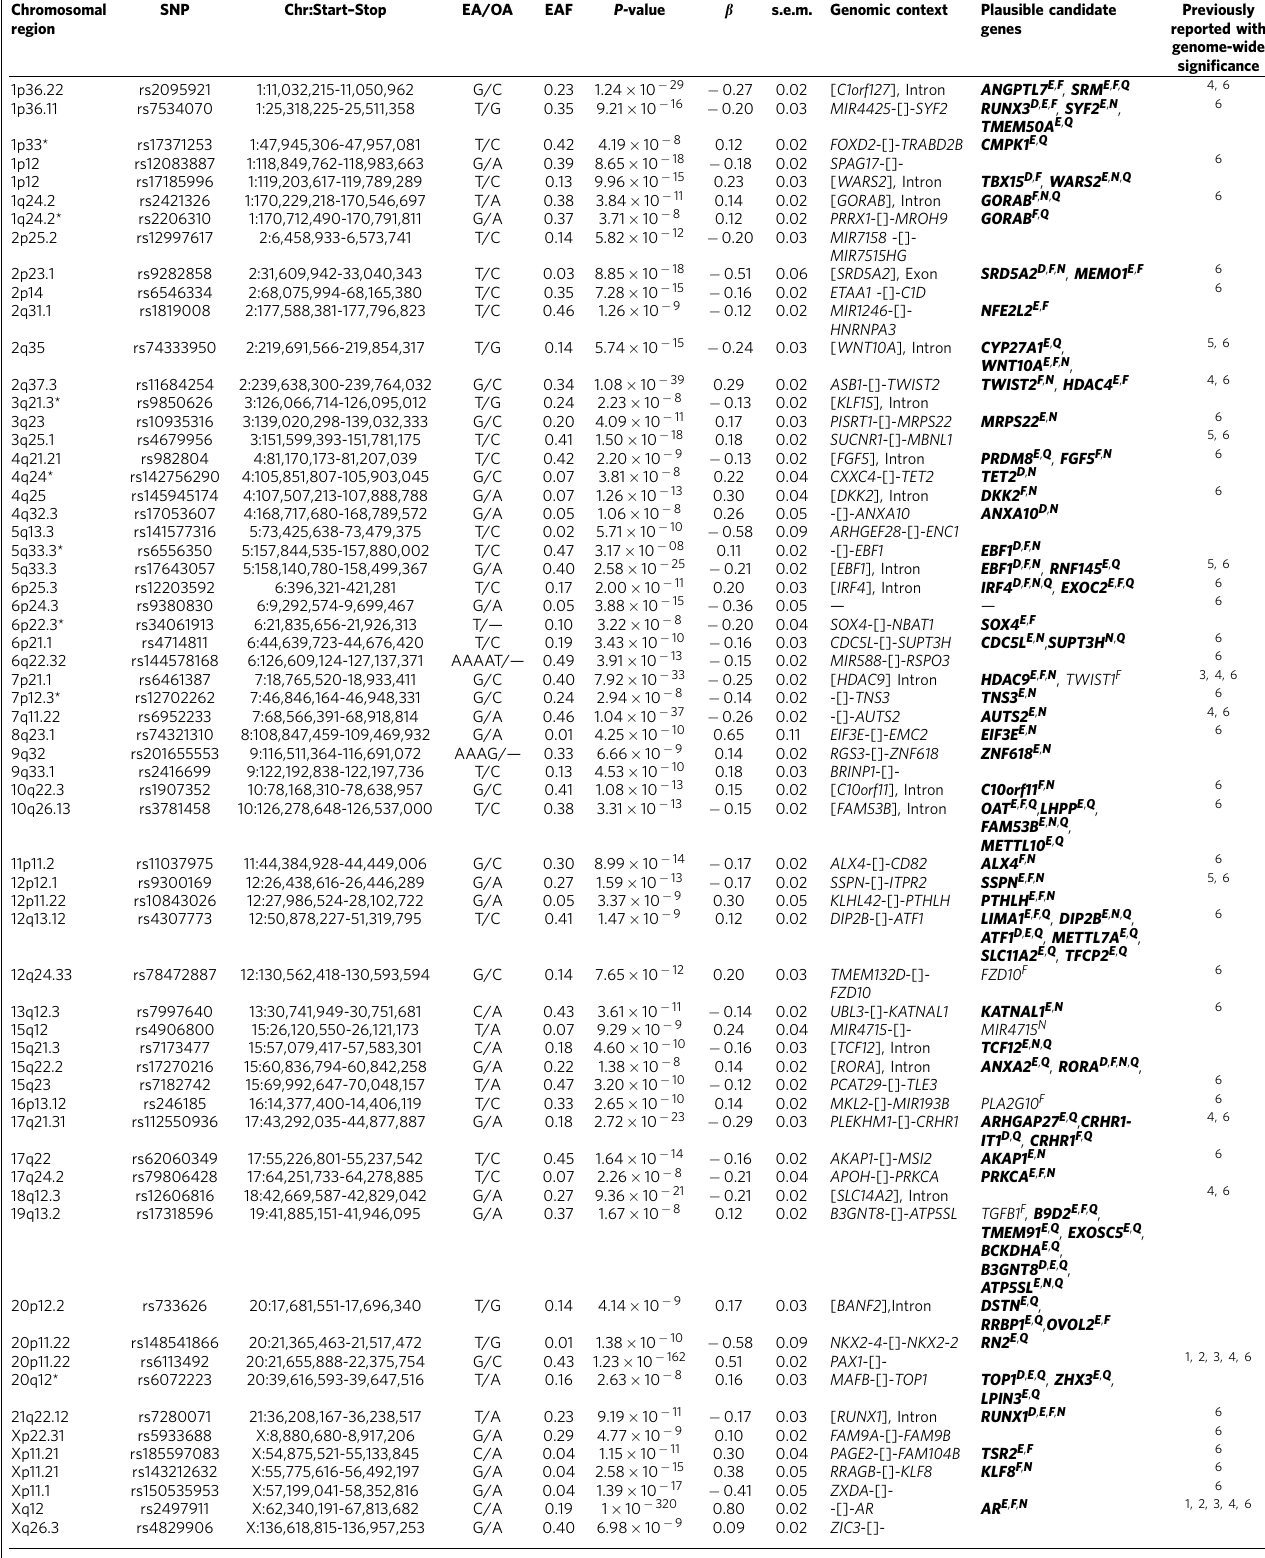
Table 1 | Summary results for the lead SNPs for the 63 genome-wide significant MPB-risk loci. Chromosomal